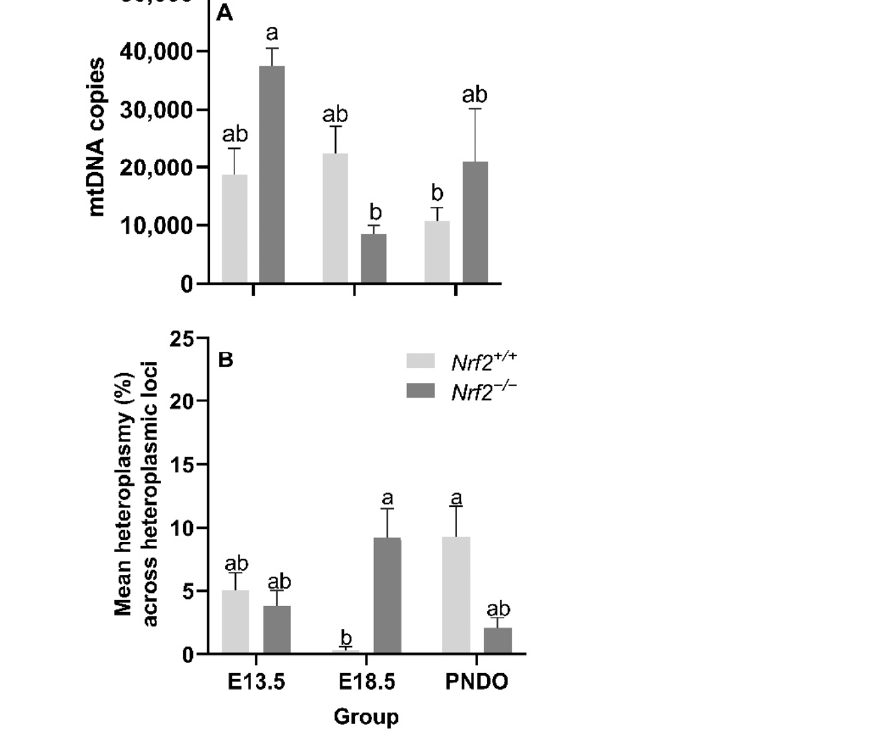
Figure 3. Effect of Nrf2 deletion on lung mitochondrial genome diversity during embryonic de- velopment and at birth. ( A ) Mitochondrial DNA copy number (mtDNA copies/3 ng/ µ L DNA) was determined in wild-type ( Nrf2 +/+ ) and Nrf2 -deficient ( Nrf2 − / − ) mouse lungs at embryonic (E) days 13.5 and 18.5 or postnatal day 0 (PND0, day of birth) using a gene-specific qPCR assay. ( B ) Average percent mitochondrial DNA heteroplasmy frequency across heteroplasmic loci in Nrf2 +/+ and Nrf2 − / − during embryonic development and birth. Nrf2 +/+ at E18.5 ( p = 0.0003) had the lowest mean hetero- plasmy frequency across heteroplasmic loci (INSERT data) compared to all other groups (INSERT data). Mean ± S.E.M. presented ( n = 5–6/group). A two-way ANOVA was employed with age (E13.5, E18.5, PND0) and genotype ( Nrf2 +/+ , Nrf2 − / − ) as the factors. Letters were used when there